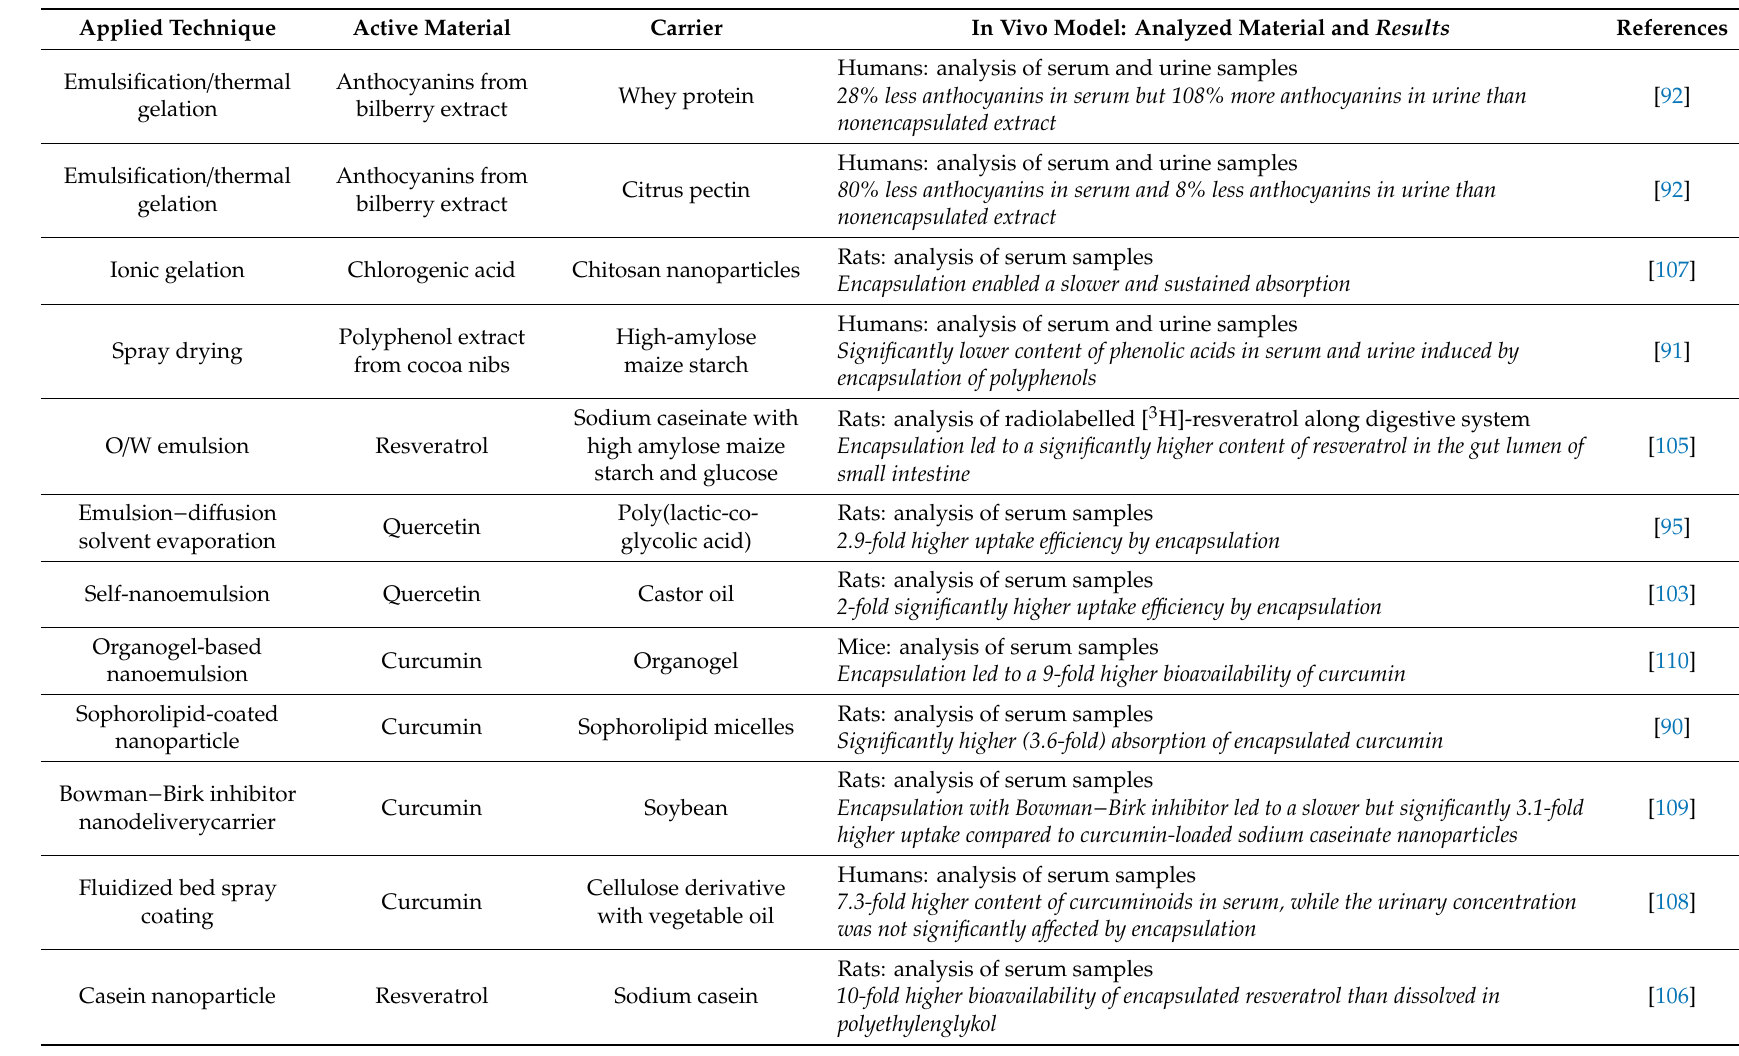
Table 3. E ff ects of lipid-based encapsulation techniques on the in vivo bioavailability of phenolic